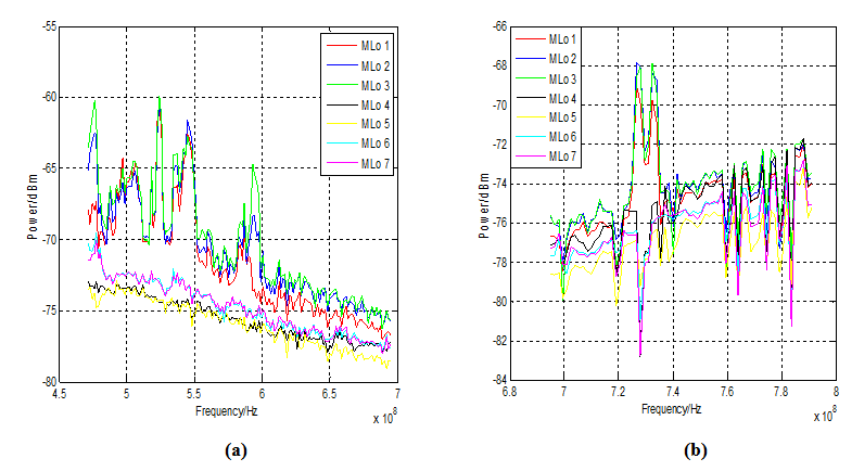
Figure 7. Radiofrequency intensities at various measurement locations for the 7 km distance from the transmitter. The frequency ranges are 470 MHz-694 MHz for (a) and 694 MHz -790 MHz for